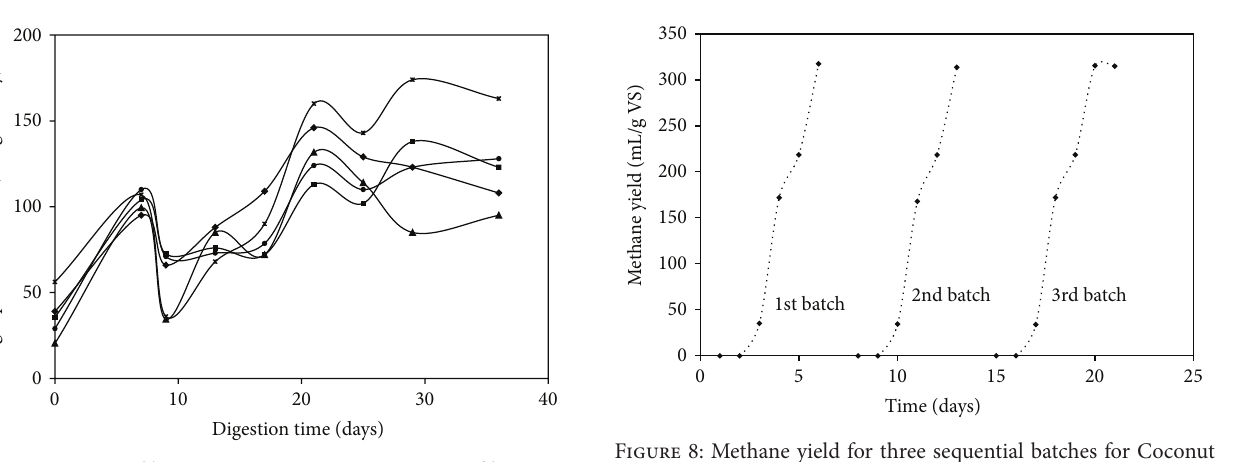
Figure 8: Methane yield for three sequential batches for Coconut oil